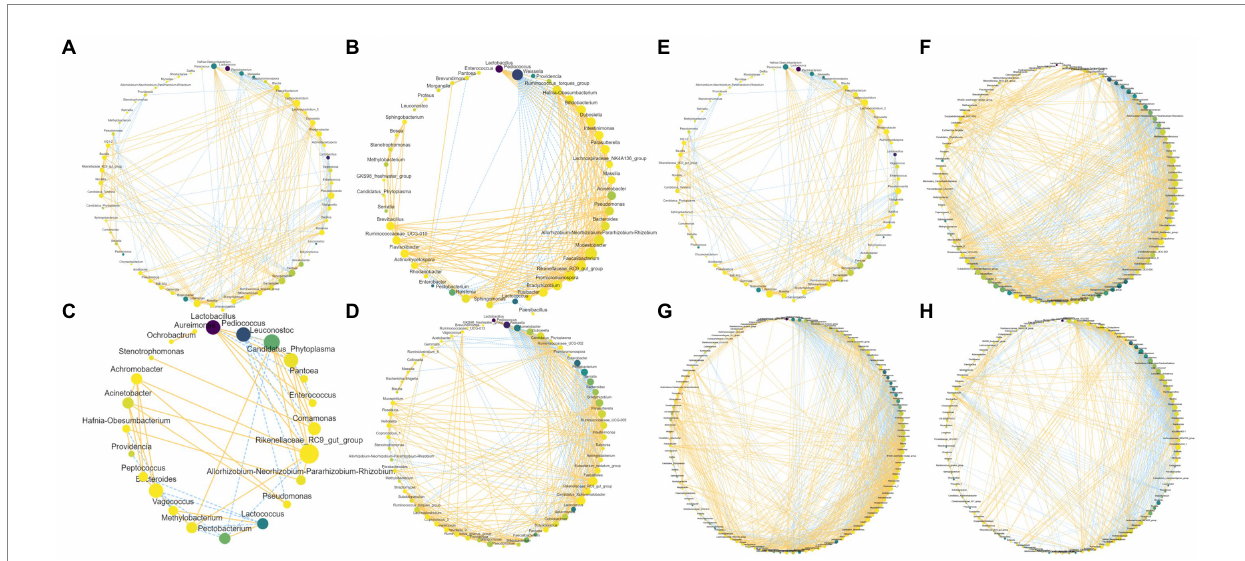
FIGURE 6 Co-occurrence network within bacteriome in Chinese cabbage waste fermented alone (A,E) and with wheat bran ( B , W1; C , W2; D , W3) or with rice bran ( F , R1; G , R2; H , R3). The node size is proportional to the connectivity of the node. The edge color represents the negative (blue) correlation and positive (yellow)